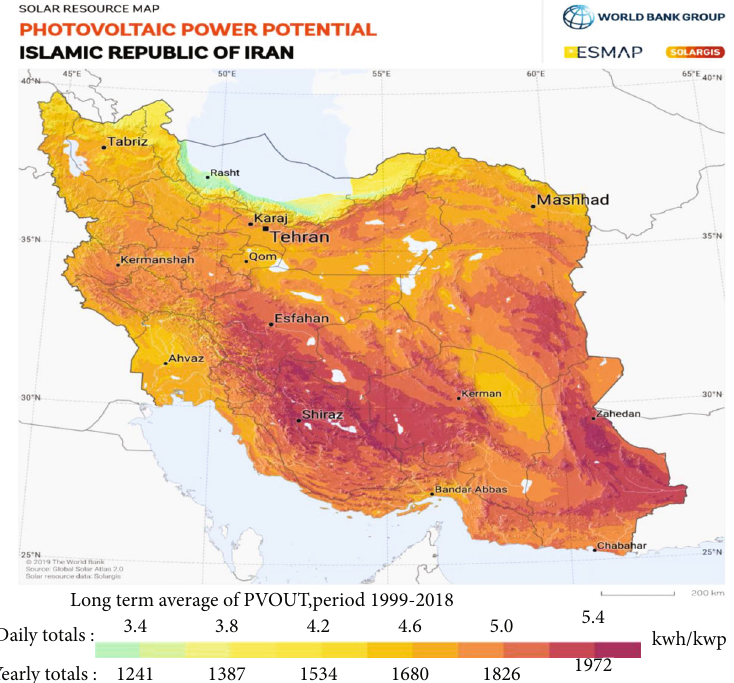
Figure 9: The distribution of solar radiation capacity in Iran.